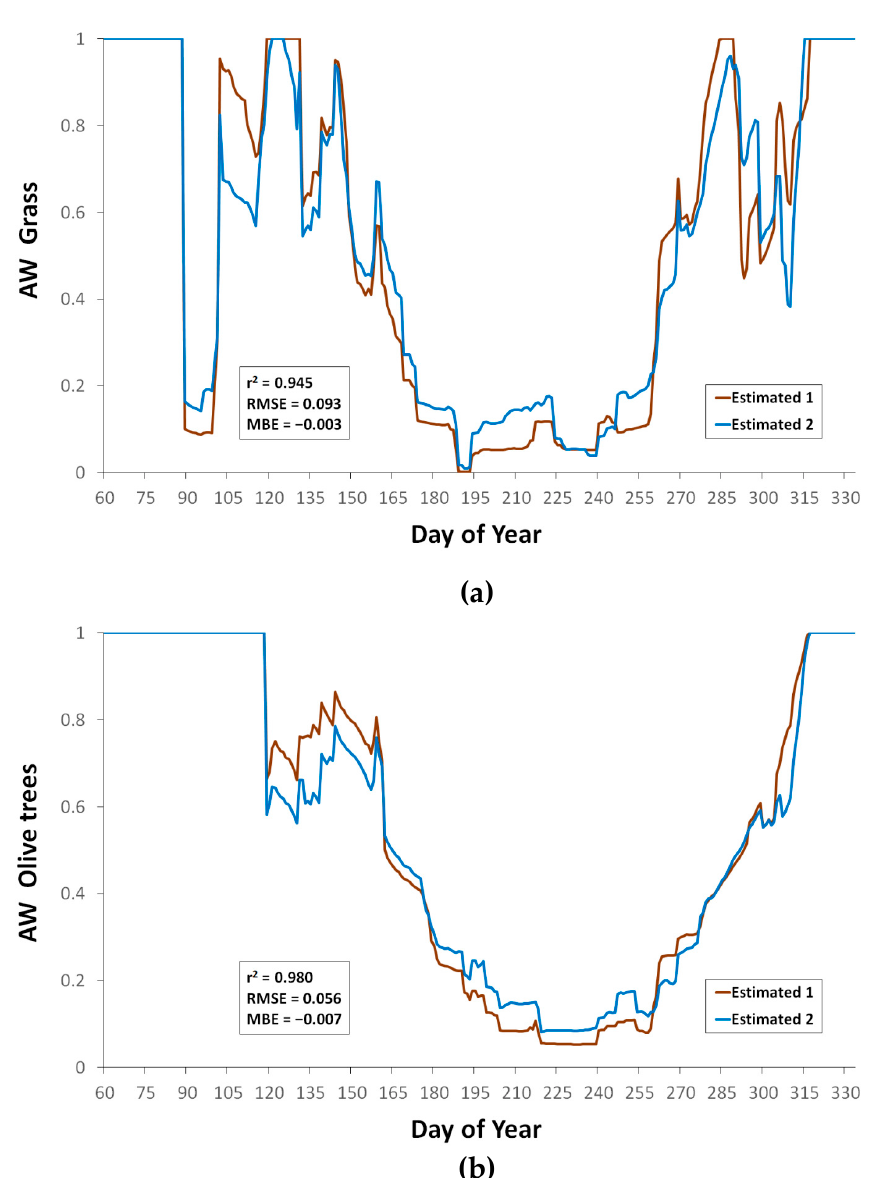
Figure 3. Daily evolutions of AW obtained from ground (Estimated 1) and combined (Estimated 2) meteorological data, computed from March to November 2021 for grass ( a ) and olive trees ( b ) at the Cascine site (all correlations are highly significant, p < 0.01).